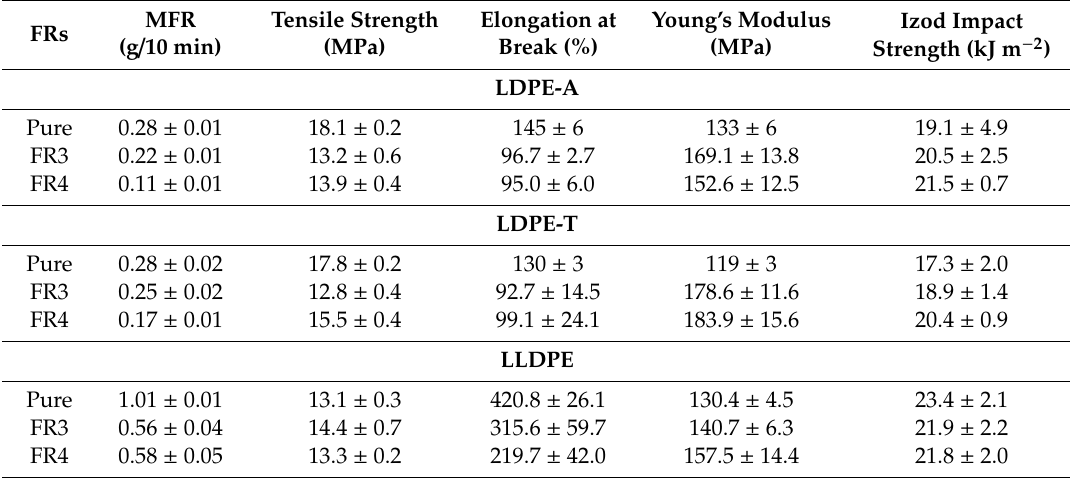
Table 2. Rheological (MFR) and mechanical properties of pure polyethylene grades and selective FR polyolefin formulations.